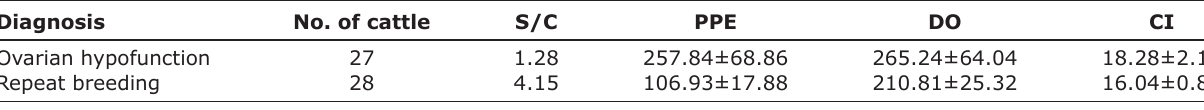
Table-1: Reproductive performance of beef cattle with ovarian hypofunction and repeat breeding in Jepara Regency. Diagnosis No. of